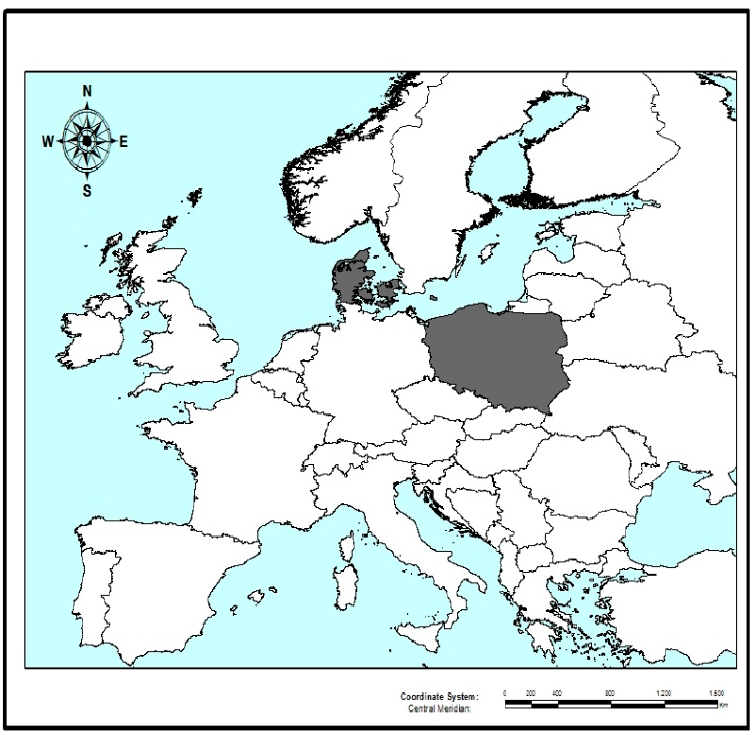
Figure 1. Map of Europe highlighting Poland and Denmark (ArcGIS ® Esri, 2016).